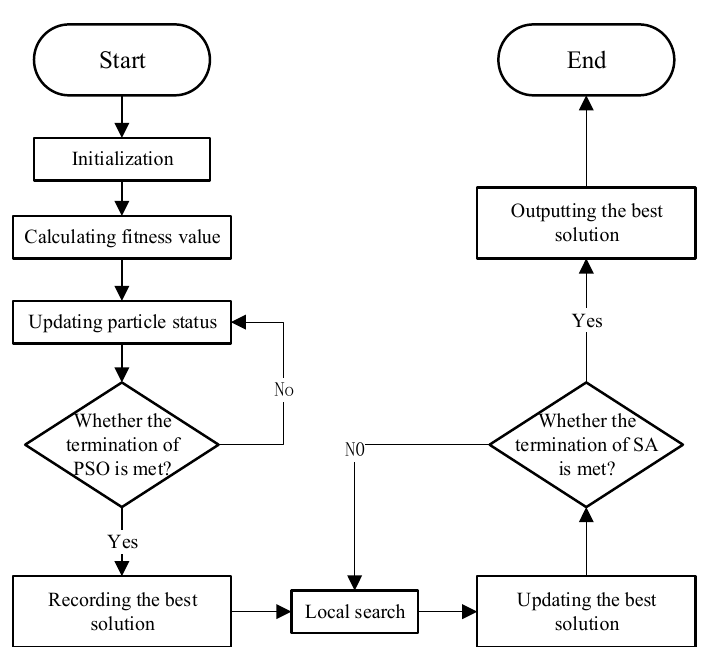
Figure 1. Flowchart of local search hybrid algorithm (LSHA).